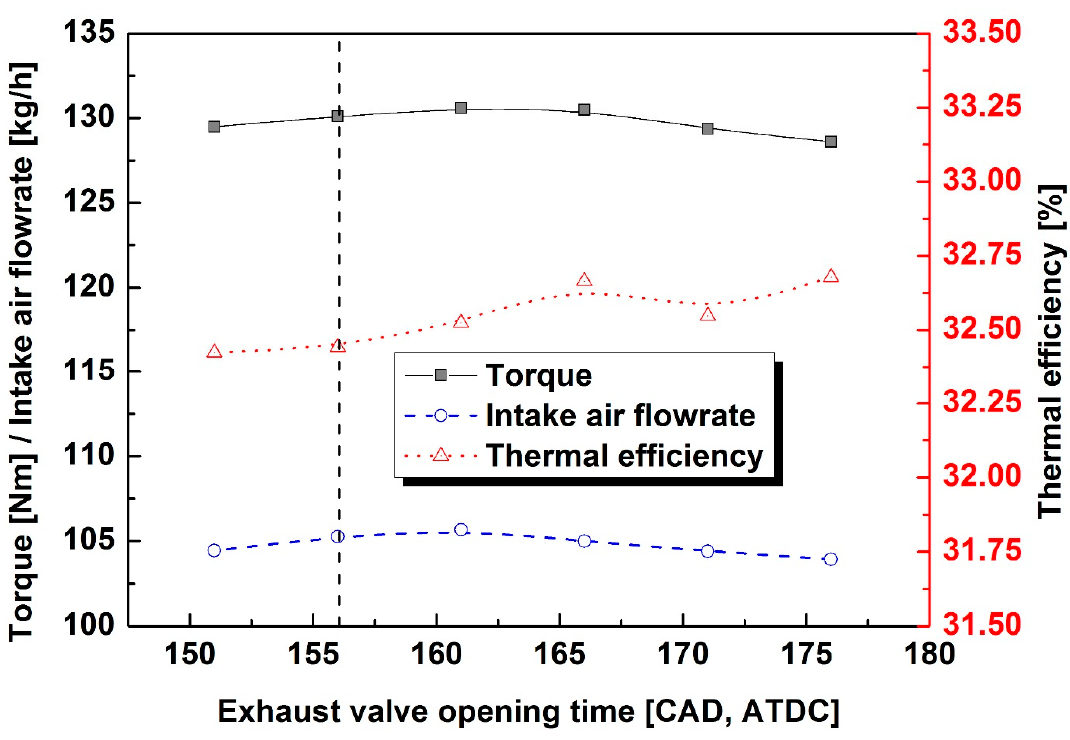
Figure 6. Torque, intake airflow rate, and thermal efficiency variations with exhaust valve opening time change at constant intake valve opening time of 327 CAD ATDC and excess air ratio of 1.25.